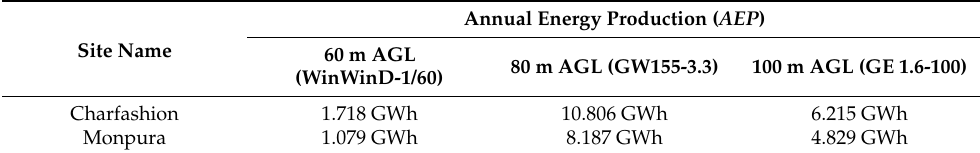
Table 13. AEP for the selected microsites.